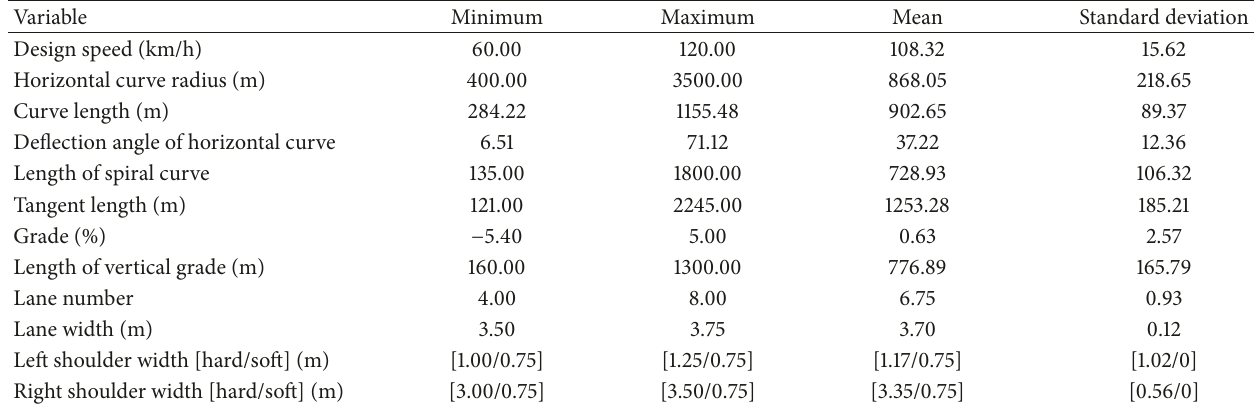
Table 1: Site geometric design